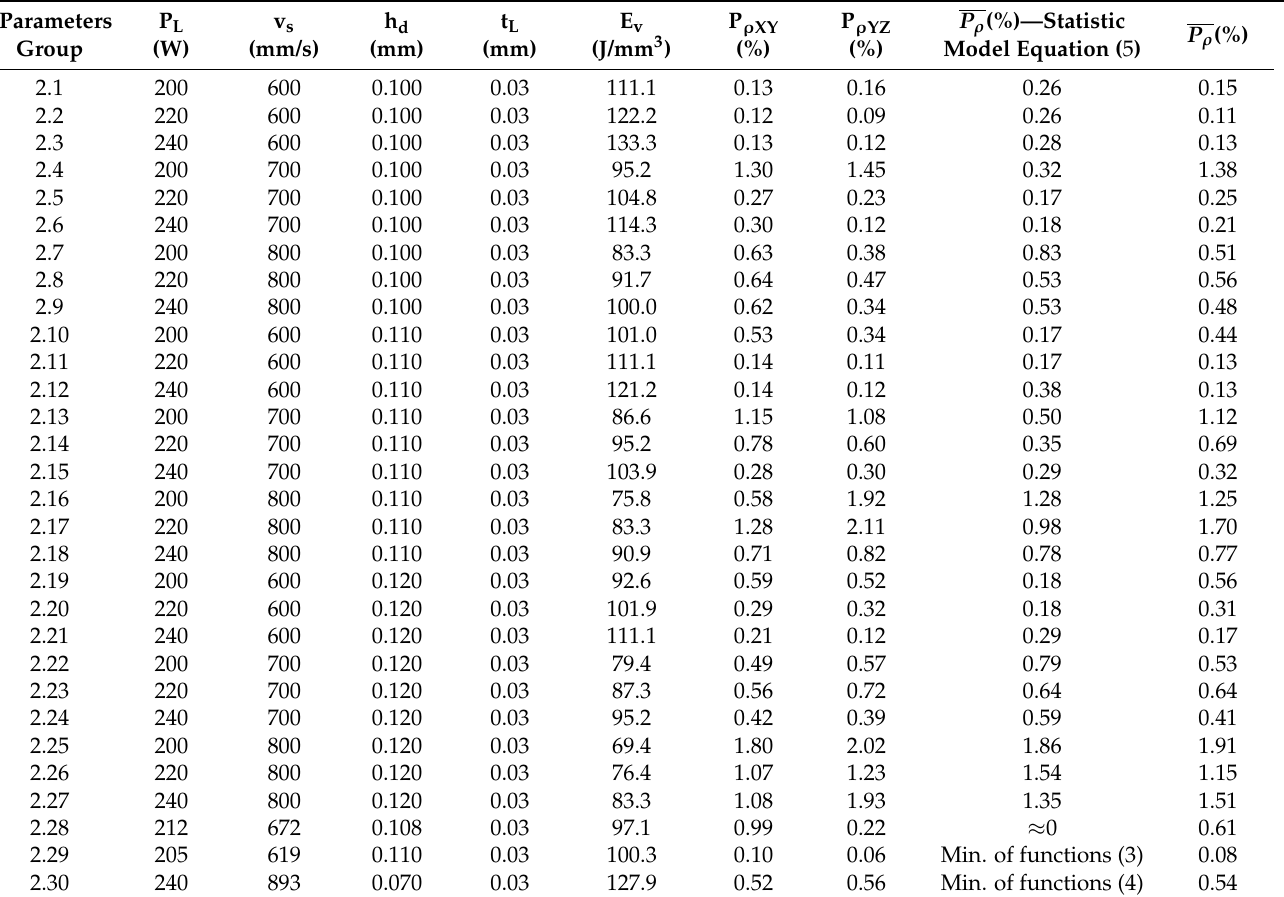
Table A2. Values of process parameters for individual groups and the measurement and prediction of results regarding the porosity of samples produced using these